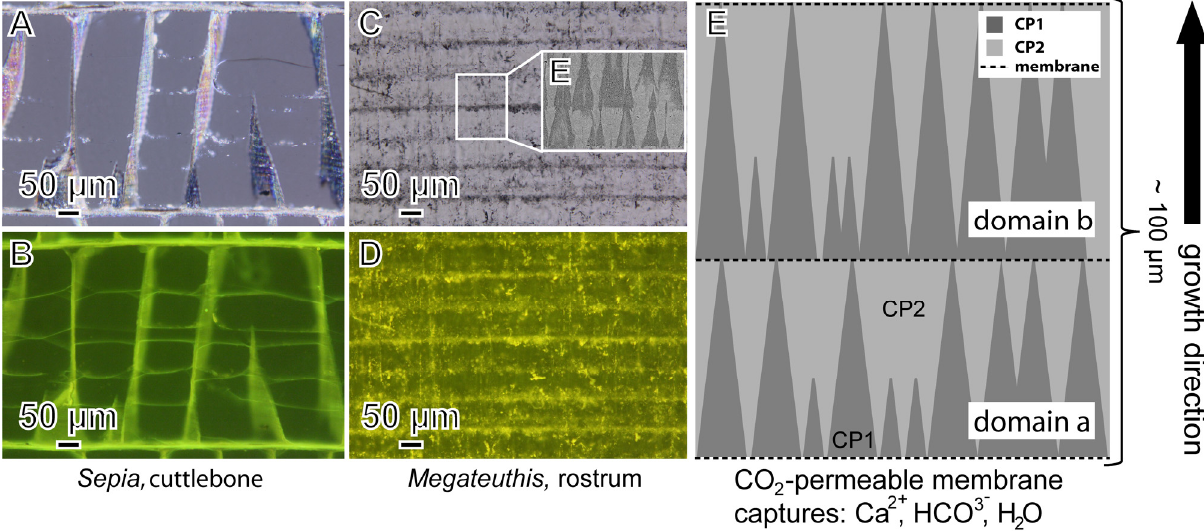
Figure 5. Precipitation model for the belemnite rostrum. ( A , B ) Sepia officinalis cuttlebone seen under ( A ) polarized light with a small scale banding of the pillars and ( B ) under the fluorescence microscope with membranes associated with growth bands [56]. ( C , D ) Cross section of a Megateuthis rostrum showing, at comparable scales, organic-rich layers, representing former organic membranes under ( C ) transmitted light and ( D ) under the fluorescence microscope; white box in C shows a BSE image [19] of trigonal pyramids (CP1), as depicted in the model ( E ), with slightly variable distances between each layer. ( E ) Scheme of calcite phases in cross-section view showing the growth model: 1, two organic membranes form a delineated space; carbonic anhydrase is associated with these membranes; 2, CP1 in domain a precipitates with its trigonal pyramid morphology determined by organic framework; 3, forming of an organic framework and isolating membrane for CP1 in domain b; 4, CP1 in domain b precipitates simultaneously with CP2 of domain a. The process repeats with continued organic matter scaffolding growth (see Supplementary for additional information).